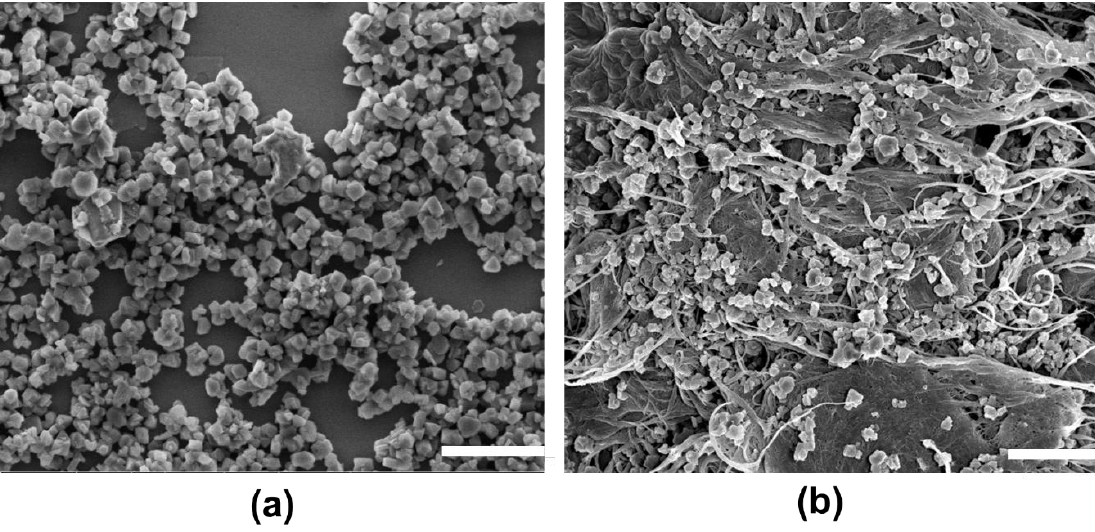
Figure 11. SEM images of coked catalysts: ( a ) NHYZ, and ( b ) NHYZ/CNS, scale bar = 5 µm.